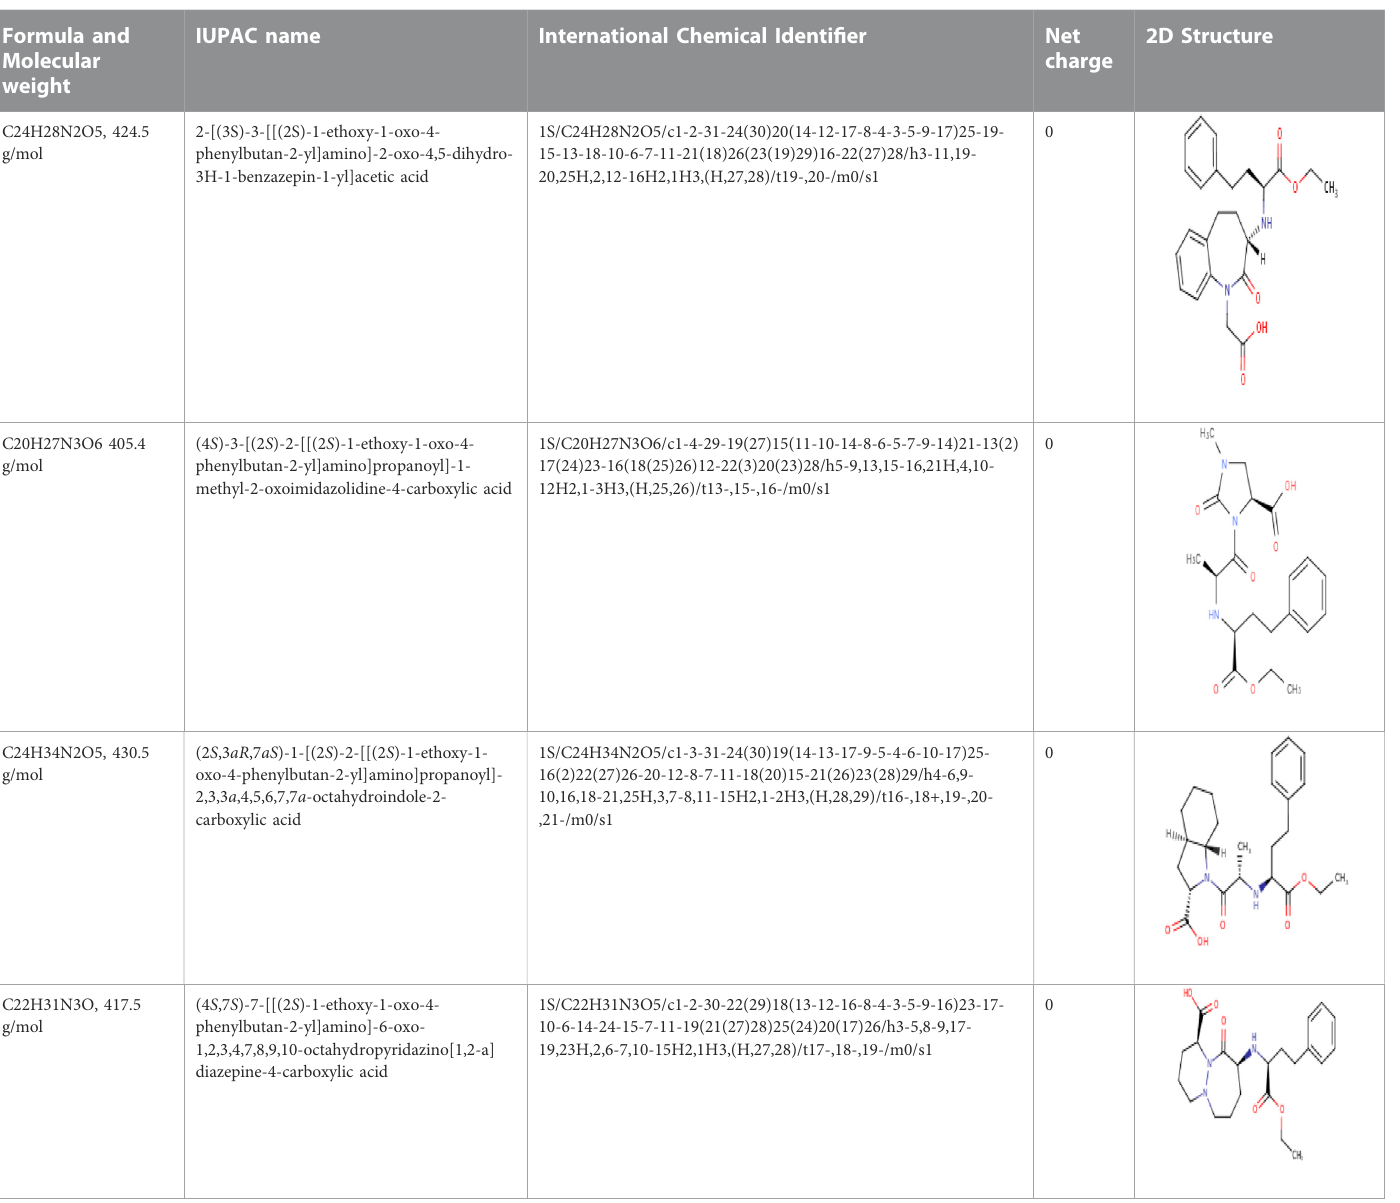
TABLE 2 ( Continued ) Molecular structural details of RAAS inhibitors (Ref: